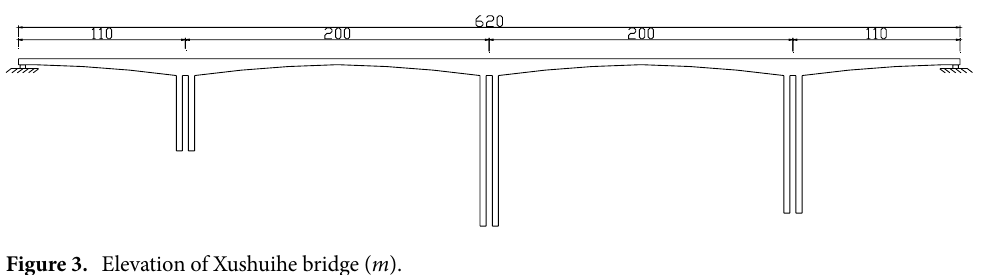
Figure 3. Elevation of Xushuihe bridge ( m